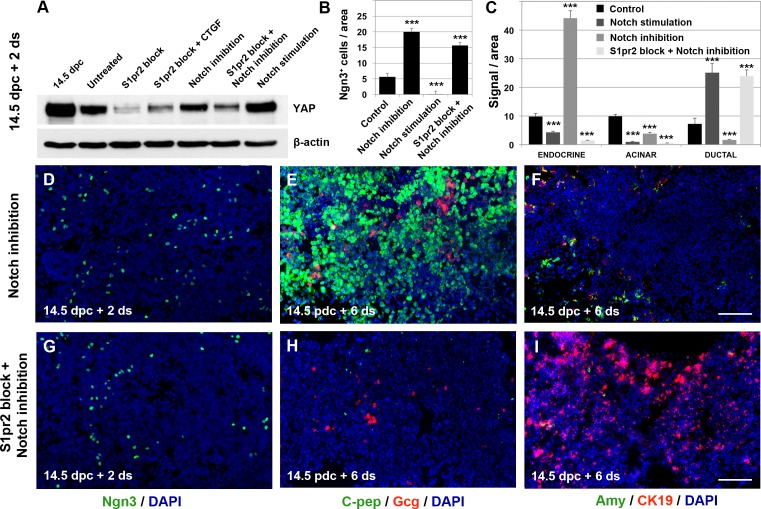
S1pr2-mediated Notch attenuation triggers endocrine and acinar differentiation.(A-C) Stimulation of Notch signalling with 10 μM DSL in 14.5 dpc + 2 d ALI cultures did not affect YAP protein levels, as shown by western blot analysis (A) but resulted in elimination of Ngn3+ cells (B, immunostaining in S8A Fig) and a significant reduction in the number of endocrine and acinar cells in favour of an expanded population of ductal cells (C, immunostainings in S8B and S8C Fig). (A-C, D-F) Inhibition of Notch signalling with 10 μM DAPT in 14.5 dpc + 2 d ALI cultures had no effect on YAP protein levels (A) but resulted in a large increase in the number of Ngn3+ (B, D), C-pep+, and Gcg+ (E, C) cells at the expense of Amy+ and CK19+ cells (F, C), as shown by immunofluorescence. (A-C, G-I). Simultaneous inhibition of Notch and S1pr2 signalling in 14.5 dpc + 2 d ALI cultures transiently resulted in a large increase in the number of Ngn3+ cells (B, G) shown by immunofluorescence. However, immunofluorescence analysis showed that C-pep+, Gcg+ (H, C), and Amy+ (I, C) cells were eventually eliminated in favour of an expanded population of CK19+ cells (I, C). Absence of terminally differentiated endocrine and acinar cells can be attributed to a significant reduction in YAP protein levels observed under these conditions (A). Scale bars, 80 μm (D-I); ***p < 0.001 in reference to control ALI cultures (B); error bars in B show SEM; error bars in C show SD. For raw data, please refer to the S1 Data file.